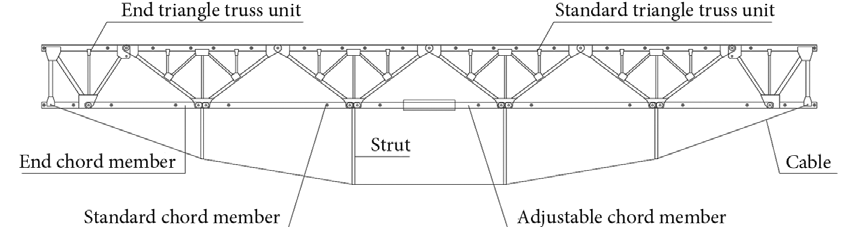
Fig. 1. Major components of the TSS (truss string structure)